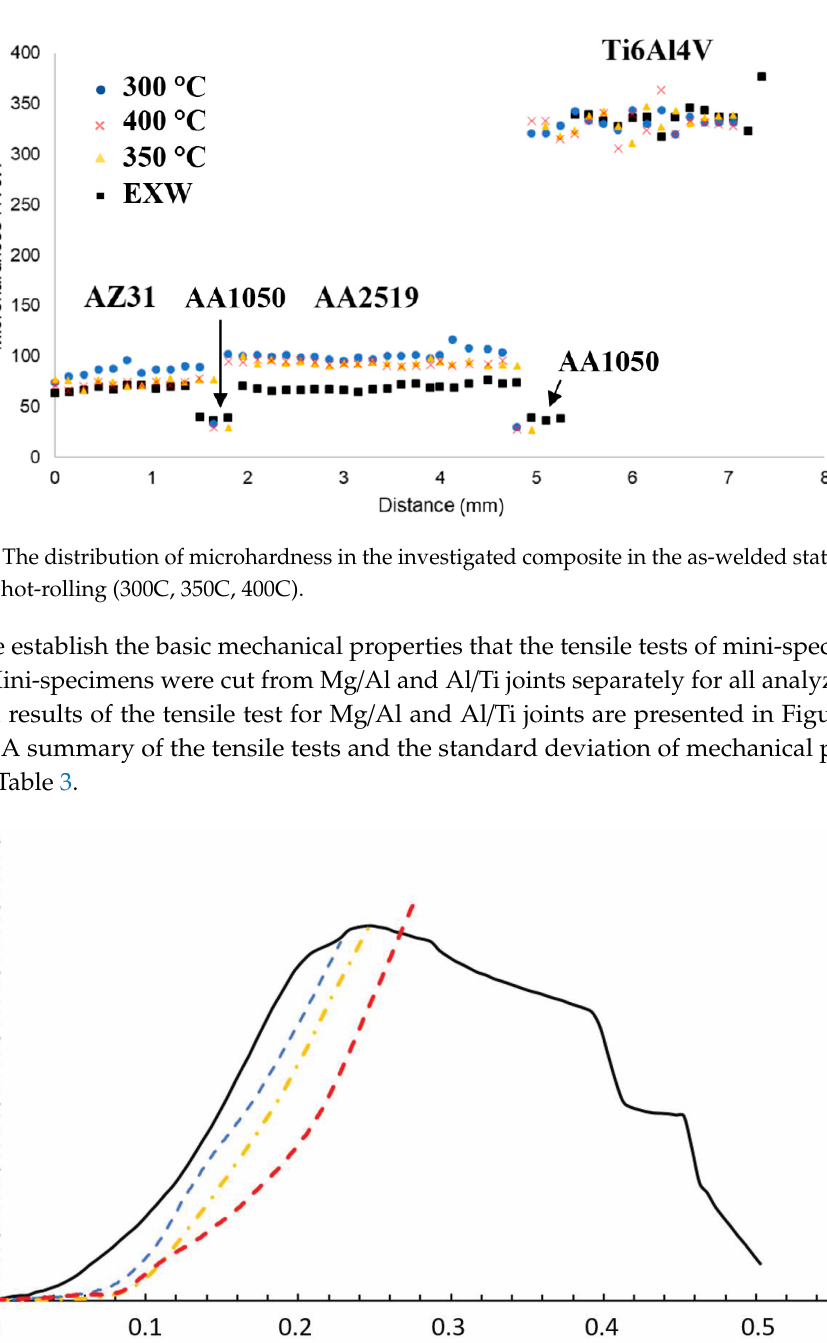
Figure 5. The tensile curves for Mg/Al interface in the as-welded state (EXW) and after hot-rolling (300C, 350C, 400C).